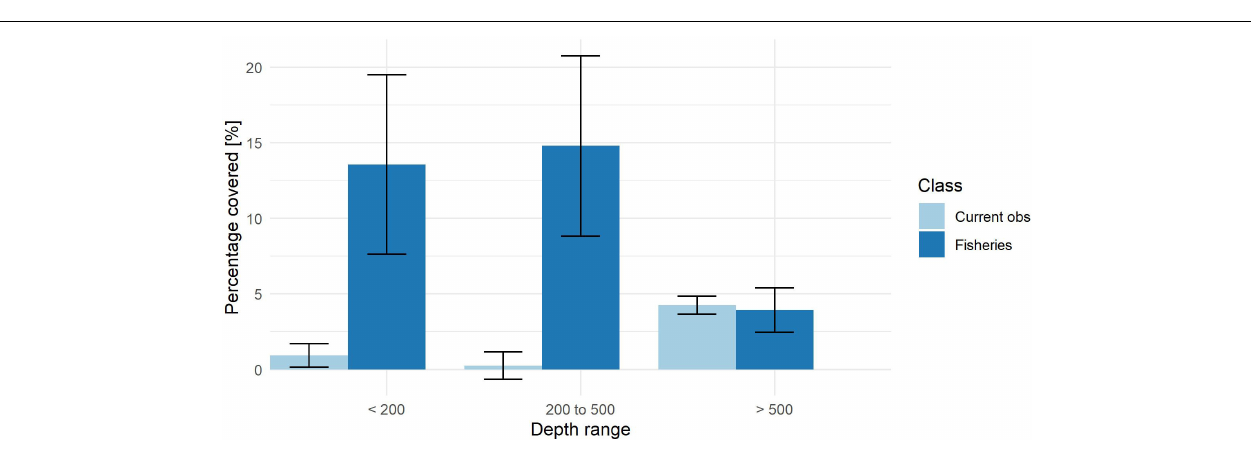
FIGURE 6 | The Alaska region monthly mean global data sub-surface observation and fishing coverage per depth category. Existing observations (light blue) and Fisheries (dark blue) indicate the percentage of the ocean area within a depth class where data were collected or fishing activity occurred. Standard deviation is shown with the error bars to quantify temporal variability of coverage between